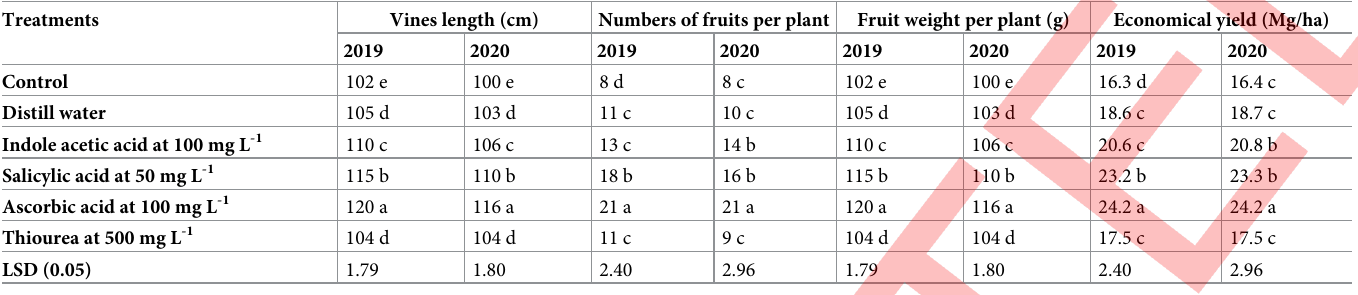
(P � 0.05) higher germination percentage (39 and 47%) and germination index (57 and 58%) were recorded for seed priming with AA during 2019 and 2020, respectively compared to con- trol treatment of the study (Table 2). Moreover, during 2019, the germination percentage for seed priming with salicylic acid (SA) at 50 mg L -1 was statistically at par with AA. Furthermore, seed priming with AA shortened the time taken for mean germination by 25 and 28% during 2019 and 2020, respectively. During 2019 and 2020, the mean germination time of control, dis- tilled water and thiourea at 500 mg L -1 were statistically similar. Moreover, seed priming with AA significantly increased (by 23 and 22%) the plant height as compared to control during 2019 and 2020, respectively. Briefly, AA followed by SA was concluded to be more useful in improving seed germination and growth performance of Indian squash than control, thiourea at 500 mg L -1 , hydropriming and indole acetic acid (IAA) at 100 mg L -1 during the study (Table 2).